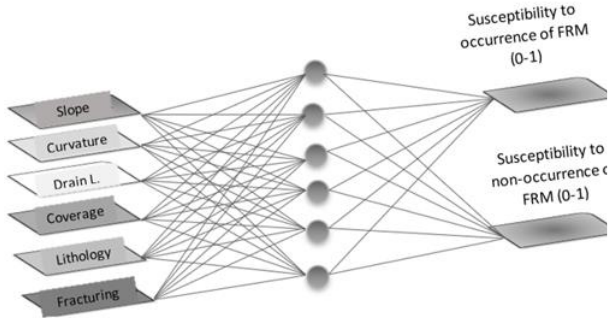
Figure 3. Artificial neural network architecture